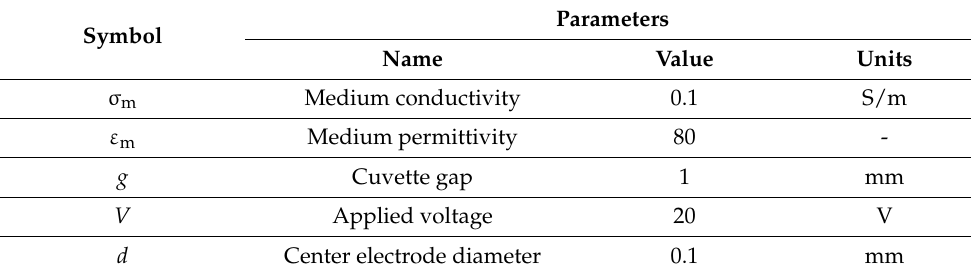
Table 1. FEM model